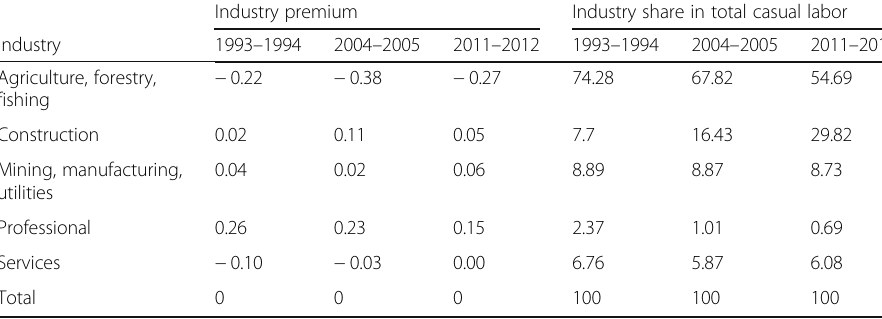
Table 6 Estimated industry premia and casual labor